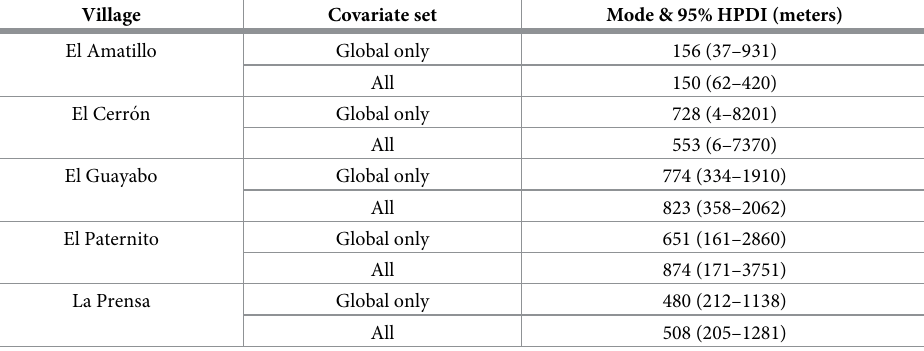
Table 1. Posterior of the effective range from the full-village analysis. Each posterior is fit according to the model of Section 2.2, using two different sets of covariate information. The 95% highest posterior density interval (HPDI) is the smallest interval such that 95% of the posterior mass is contained within